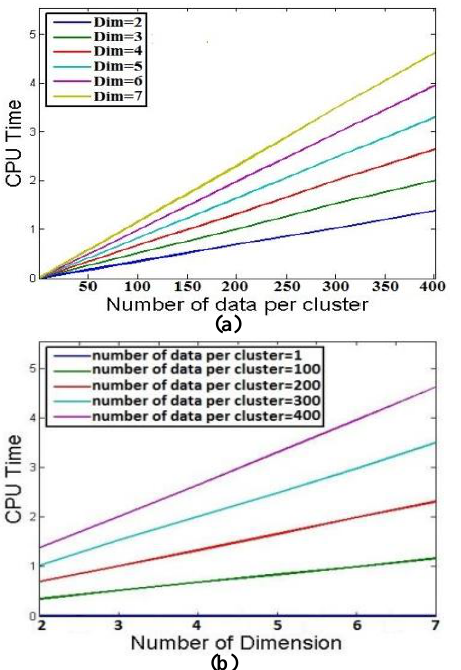
Figure 11. a) Time complexity of the algorithm is linearly related to the number of data per cluster b) The time complexity of the algorithm is linearly related to the number of features.